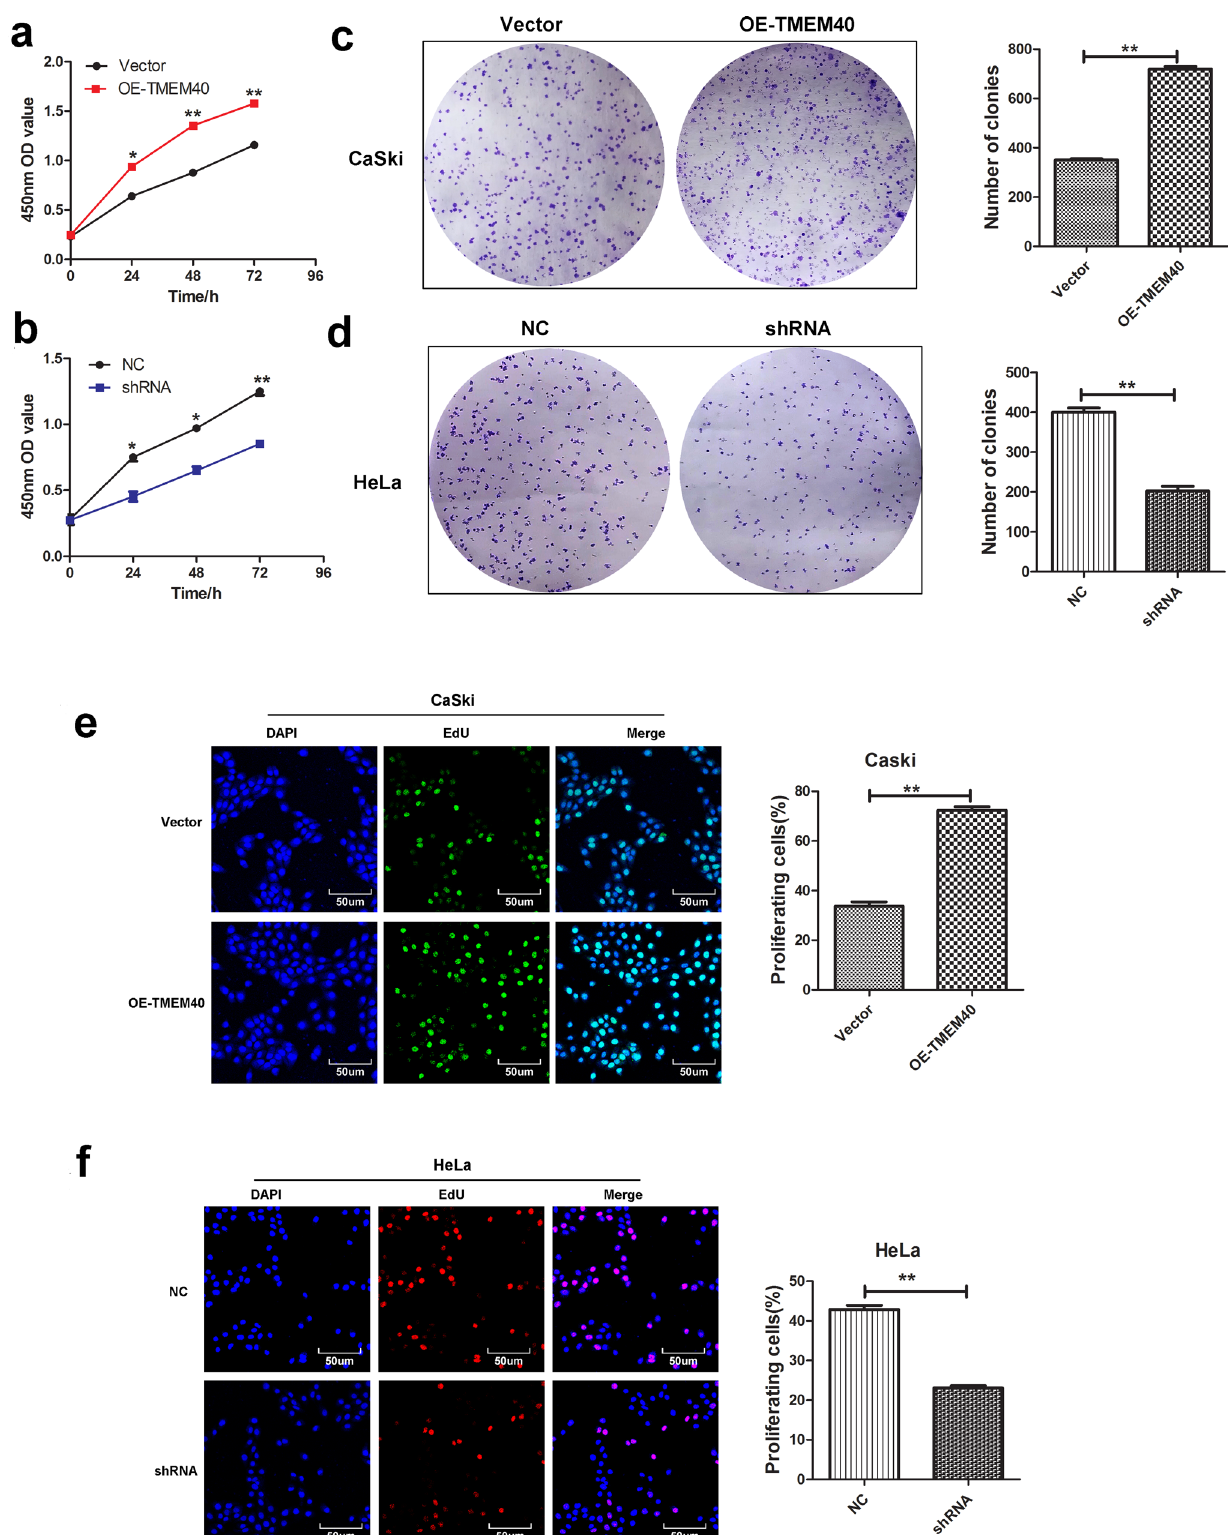
Fig. 3 Knockdown of TMEM40 expression suppresses the viability of cervical cancer cells. a and b , Growth curves of CaSki and HeLa cells transfected with OE-TMEM40 or TMEM40 shRNA vector. Cell growth was determined by CCK8. c and d, A Colony-formation assay was per- formed to determine the oncogenic growth of CaSki and HeLa cells. e and f , EdU assay was performed to examine the proliferation of CaSki and HeLa cells. * P < 0.05, ** P <